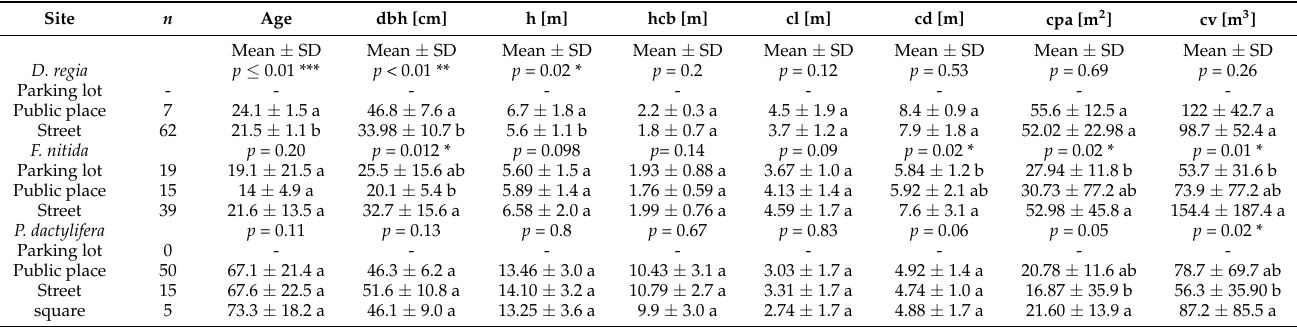
Table 4. Mean of the trees’ structural data: age, dbh, h, hcb, cl, and related SD in response to the growth site for D. regia , F. nitida , and P. dactylifera , as well as the p -value (with levels of significance indicated by symbols such as ***, ** and *) for each ANOVA. The mean in the same column differs significantly when followed by different letters. Abbreviations: (dbh) diameter at breast height; (h) tree height; (cl) crown length; (cd) crown diameter; (cpa) crown projection area; (cv) crown volume; SD, standard deviation.